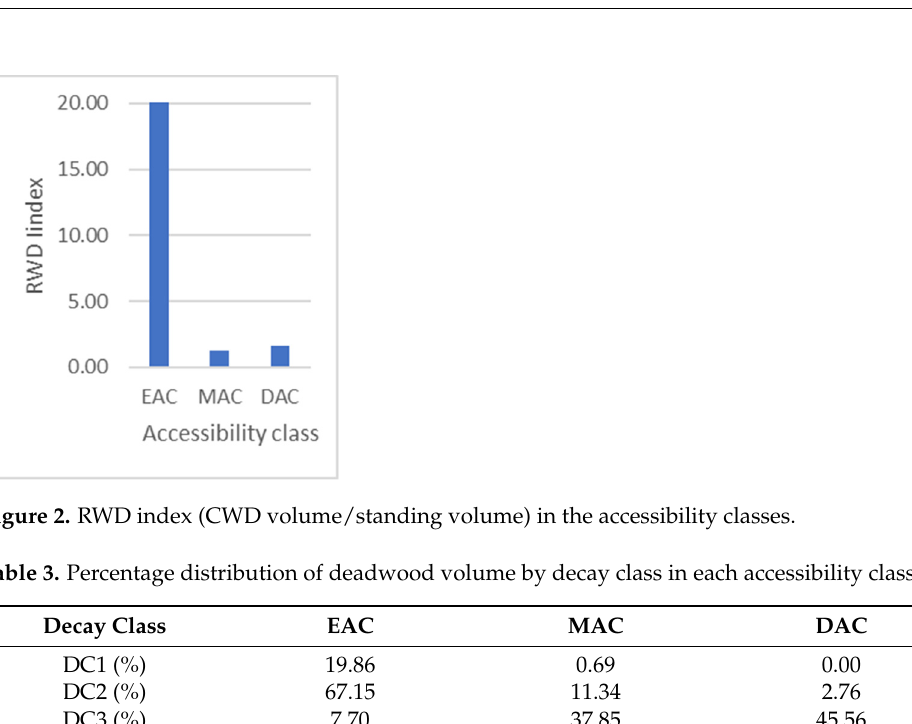
Table 3. Percentage distribution of deadwood volume by decay class in each accessibility class.